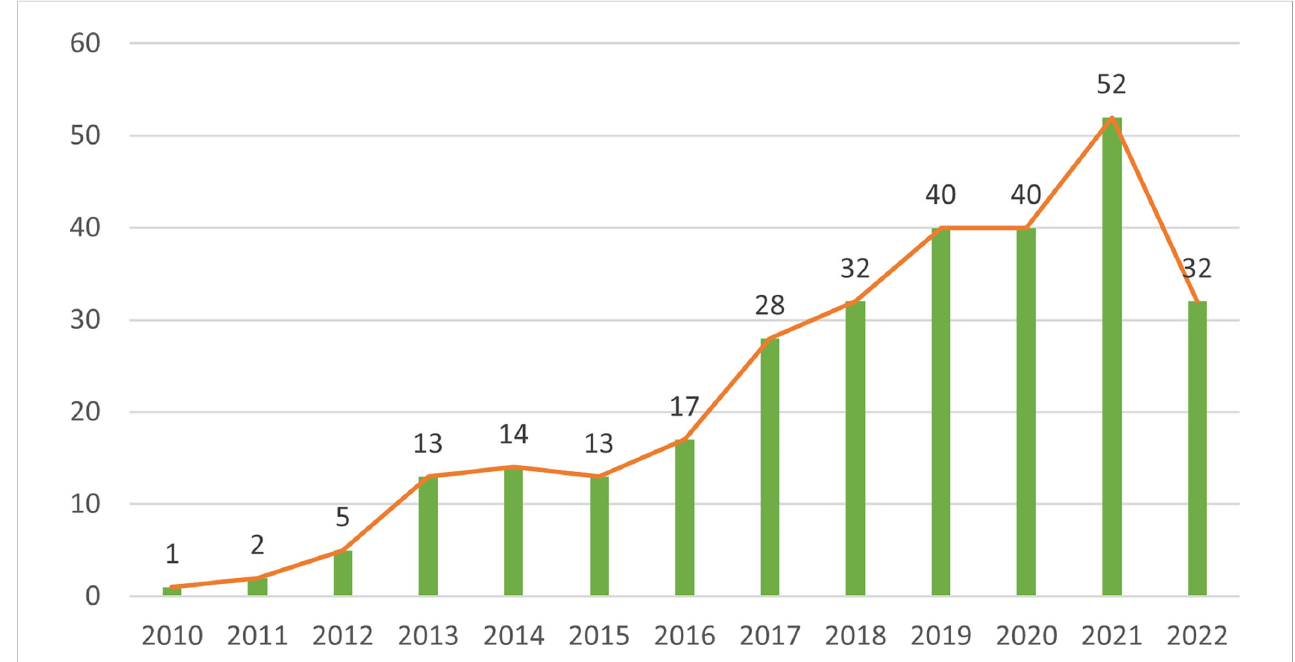
FIGURE 2 Distribution of publications of NETs in AIDs from 2010 to